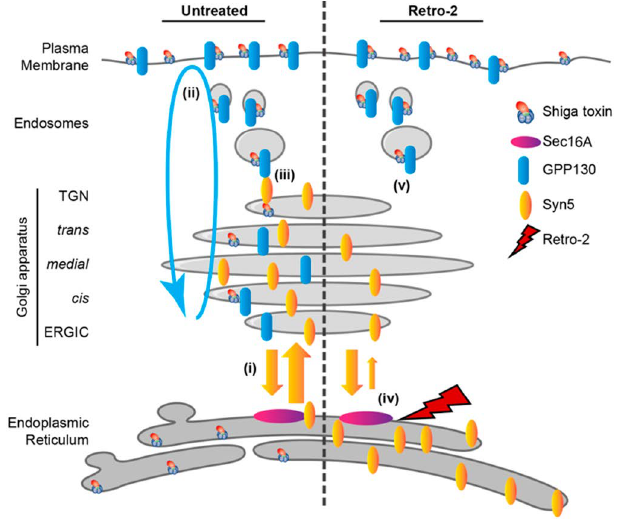
Figure 7. Model of how Retro-2 induces a block of Shiga toxin trafficking at the level of early endosomes. In untreated conditions (left), Shiga toxin trafficking from early endosomes to the TGN requires the interaction of GPP130 (blue) with syntaxin-5 (Syn5, yellow). From the TGN, Shiga toxin then moves on to the ER from where the catalytic A-subunit is translocated to the cytosol to inactivate ribosomes. Under Retro-2 treatment conditions (right), the anterograde transport of syntaxin-5 between ER and Golgi is slowed down by the interaction of Retro-2 with Sec16A, leading to the partial depletion of syntaxin-5 in the Golgi, a loss of its interaction with GPP130, and thereby the blockage of STxB in early endosomes. Reproduced with permission from Ref. [70] .